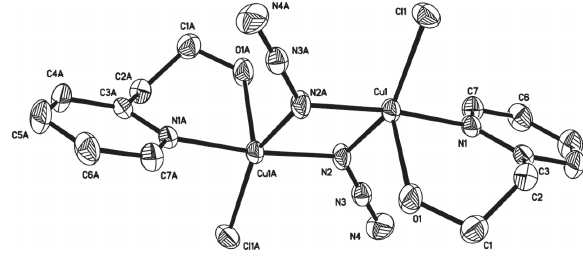
Table 1: Data collection and handling.